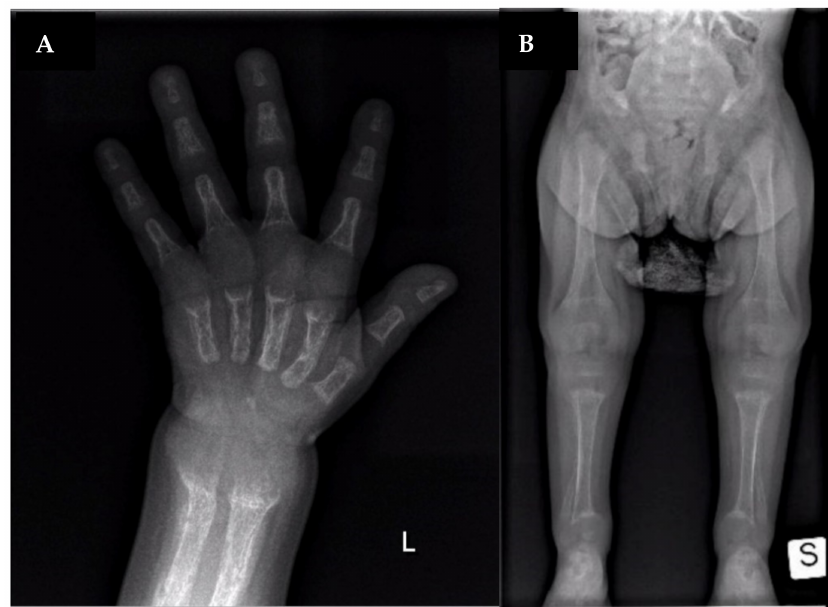
Figure 1. X-ray at diagnosis. ( A ): lateral widening of metaphyseal region; bone demineralization; fractures of metacarpus, radio, and ulna. ( B ): lateral widening of metaphyseal region; bowed fibula and tibia; bone demineralization; fractures of femur and